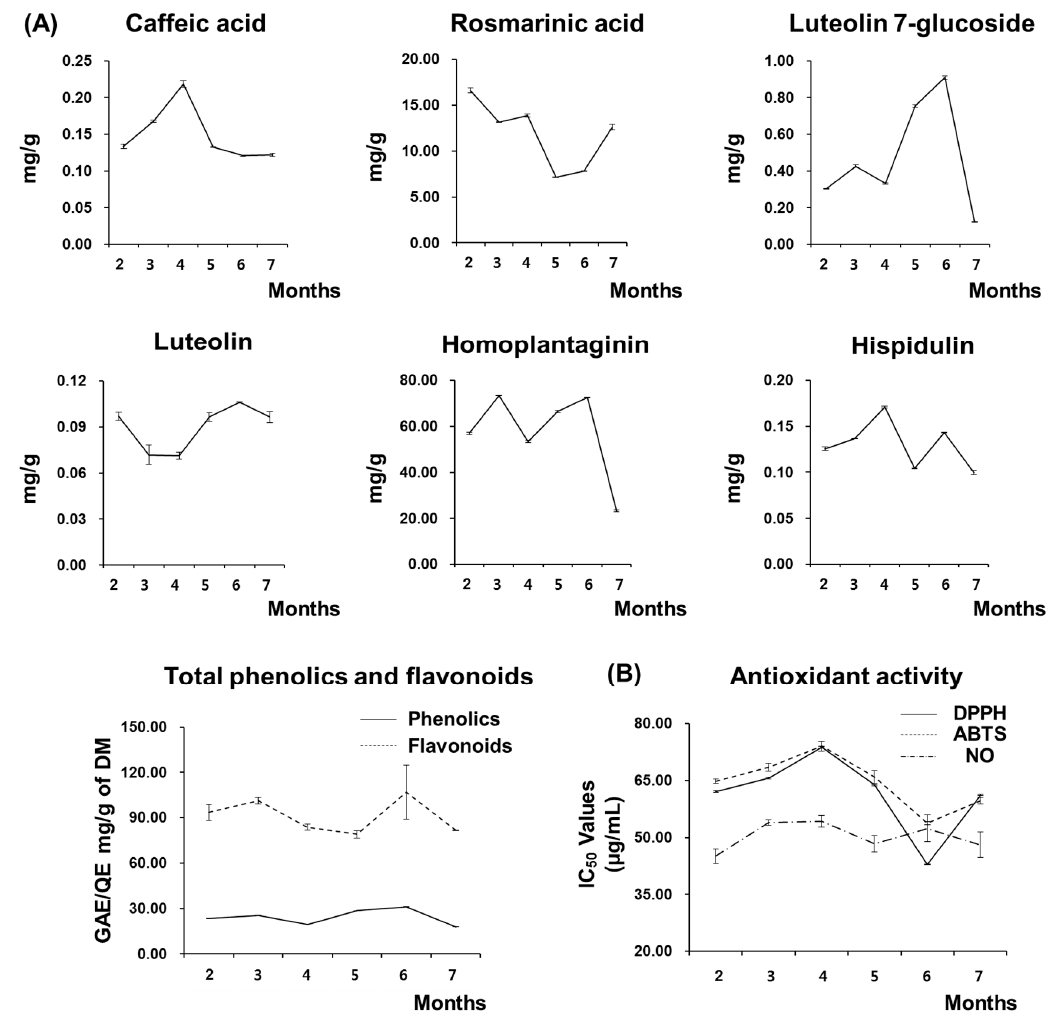
Figure 3. Total polyphenol and flavonoid contents ( A ) and radical scavenging activity ( B ) of S. plebeia in the different growing periods. The S. plebeia groups were sampled for a seven-month period (2, 3, and 4 months with fluorescent light; 5, 6, and 7 months with sunlight). The values represent the mean ± S.E. from triplicate experiments. ( DM: Dry matter; GAE: Gallic acid equivalents; QE: Quercetin equivalents; IC 50 : concentration of 50% radical scavenging or anti-inflammatory activity).